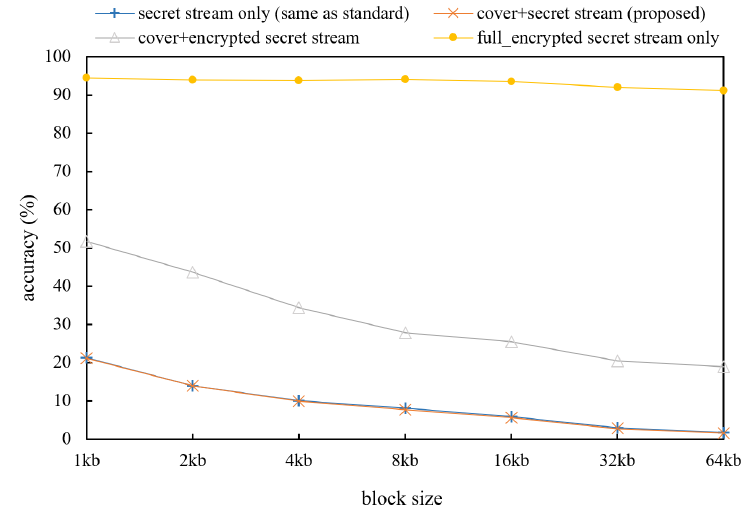
Figure 5. Encryption stream test results according to the HEDGE method for several interleaving versions of our system (higher accuracy means more encrypted streams).